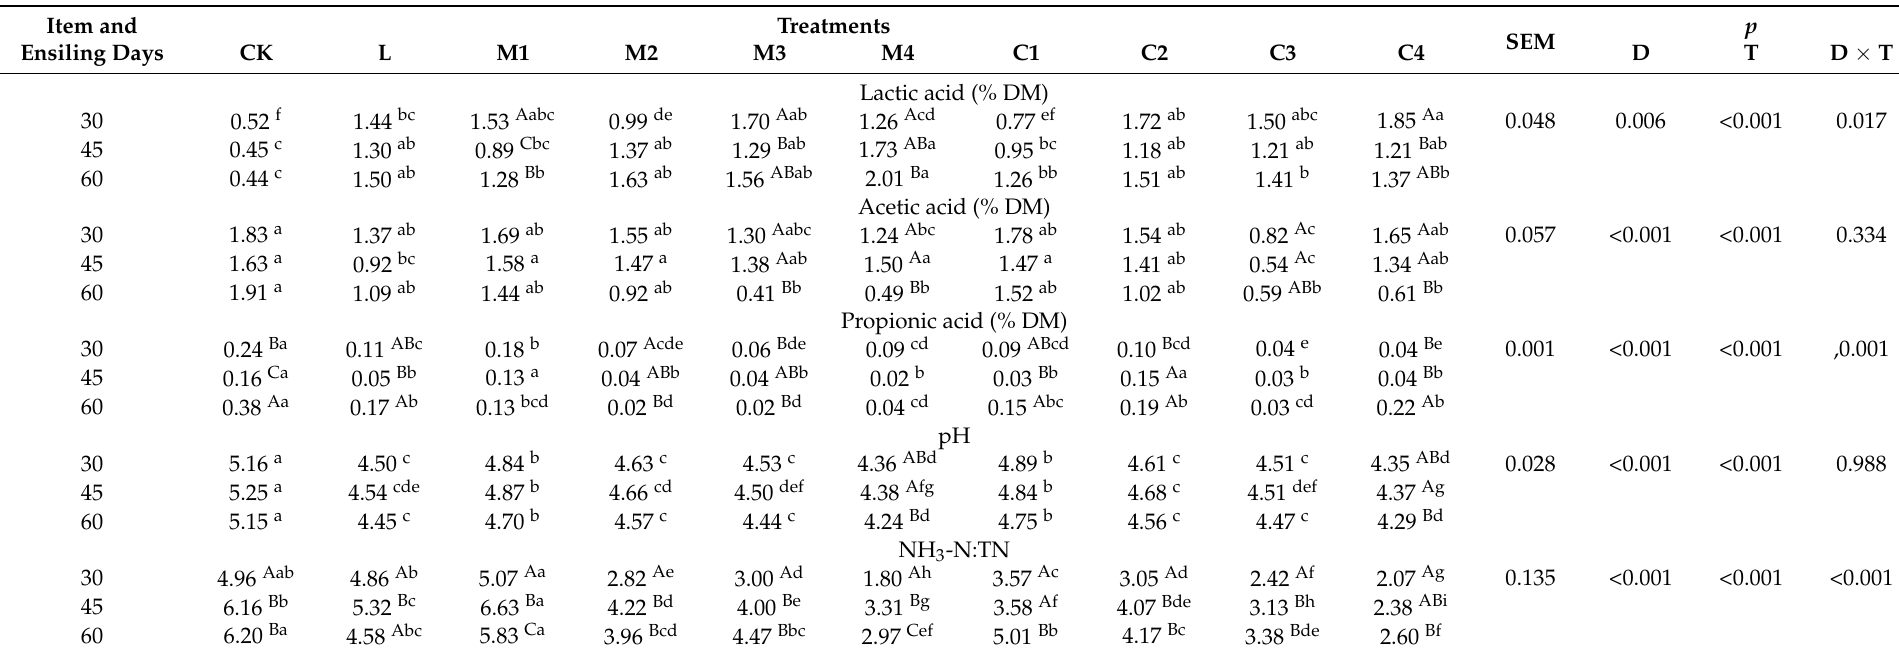
Table 3. Effect of ensiling time, and Lactobacillus acidophilus and organic acids on fermentation characteristics of the Chamaecrista rotundifolia